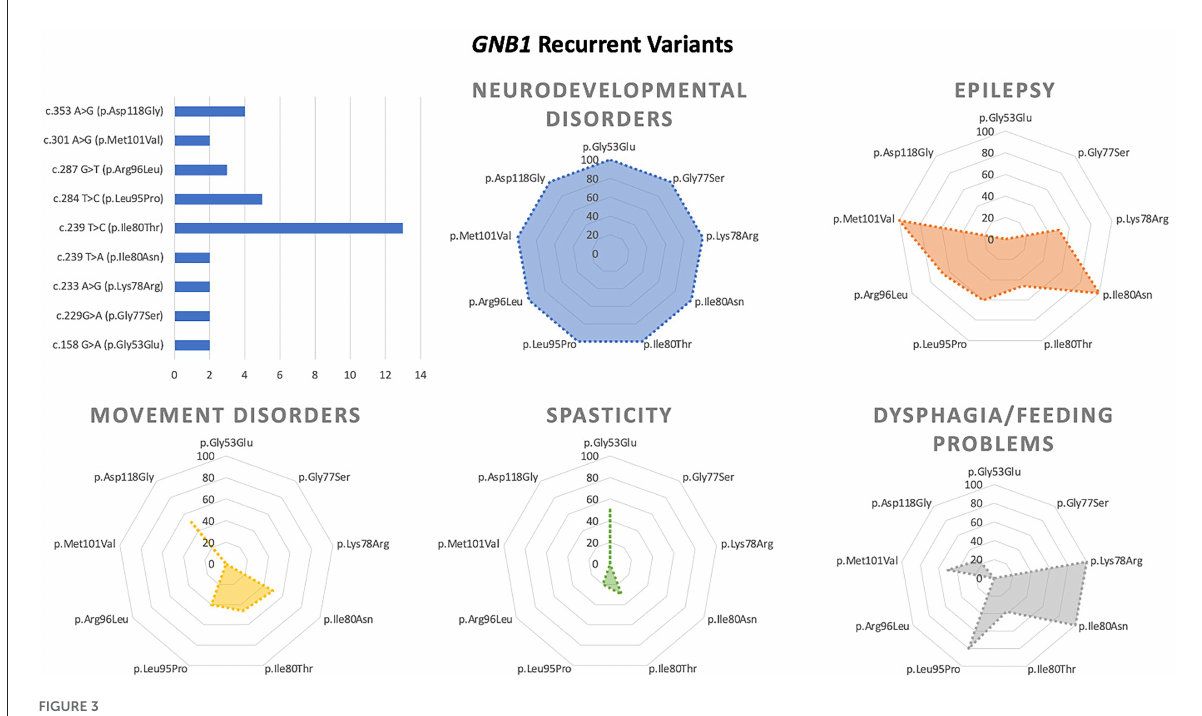
FIGURE3 Main genotype–phenotype correlations in GNB1 deficiency.